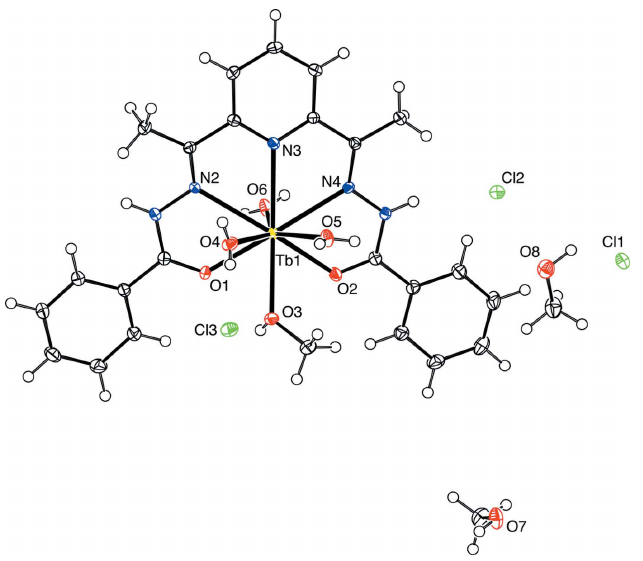
Figure 2 A view along the b axis of the hydrogen-bonded (dashed lines) layer structure of the Tb III complex. The Cl (cid:5) ions are shown as green balls and the C-bound H atoms have been omitted for clarity.